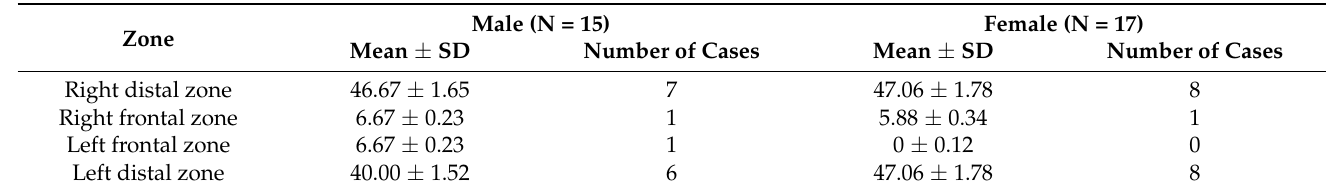
Table 3. Comparison of zones of the first contact between males and females as determined by the T-Scan